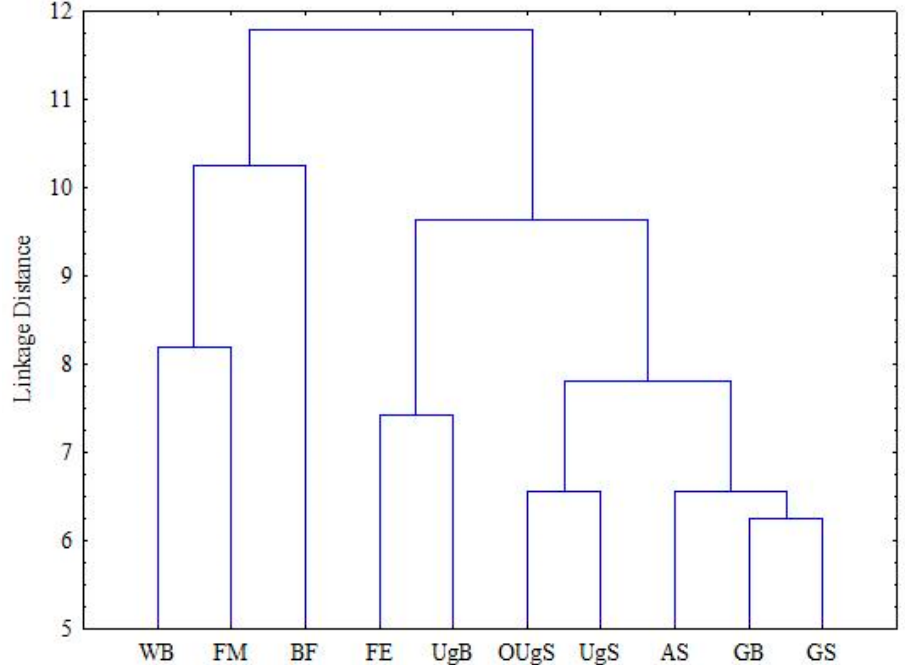
Figure 2. Dendrogram of faunistic similarity of spider assemblages of the study habitats (complete linkage, Euclidean distance). For the abbreviations, see Table 1.